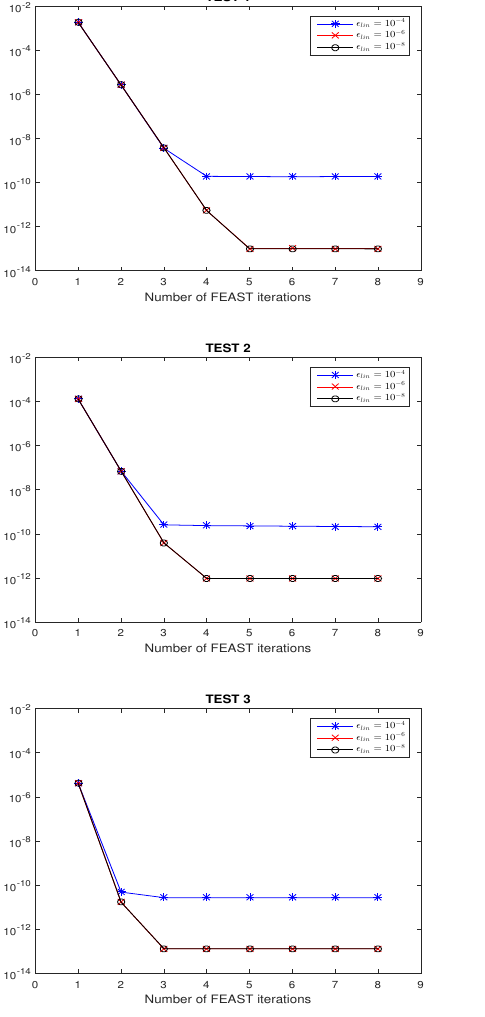
Figure 2. Convergence behavior of Algorithm 1 for TEST 1, TEST 2, and TEST 3 with ε and 10 − 8 ,